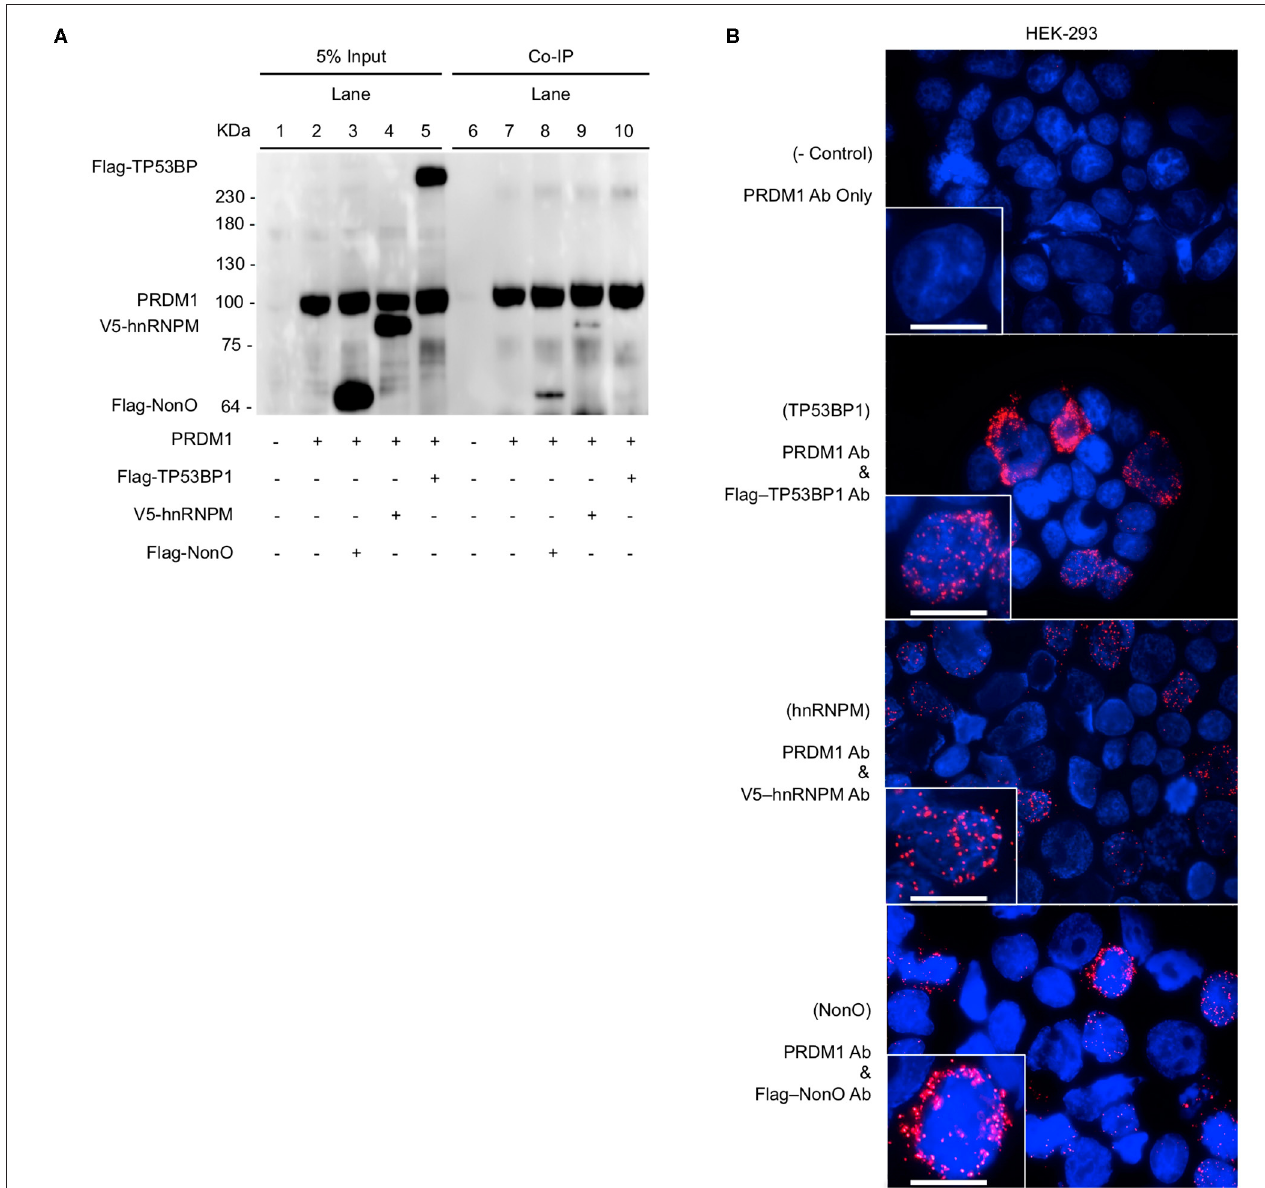
FIGURE 1 | Binding of PRDM1 and candidate proteins in HEK-293 cells. HEK-293 cells were transfected PRDM1 alone or together with Flag-NonO , Flag-TP53BP1 , or V5-hnRNPM expression vector. Binding between PRDM1 and each candidate proteins was detected by Co-IP and PLA. (A) Nuclear fraction was immunoprecipitated with anti- PRDM1 antibodies and immunoblotting was performed with anti-PRDM1, Flag-NonO, Flag-TP53BP1, or V5-hnRNPM antibody. A representative image from two independent experiments is shown. (B) Binding between PRDM1 and candidate proteins was visualized by PLA (red color) and nuclei were stained with DAPI (blue). Top panel; technical negative control PLA (PRDM1 antibody alone), other panels; detection of PLA (PRDM1 with Flag or V5 Ab). Scale bar = 10 µ m. A representative image from three independent experiments. Co-IP, co-immunoprecipitation (Co-IP); PLA, proximity ligation